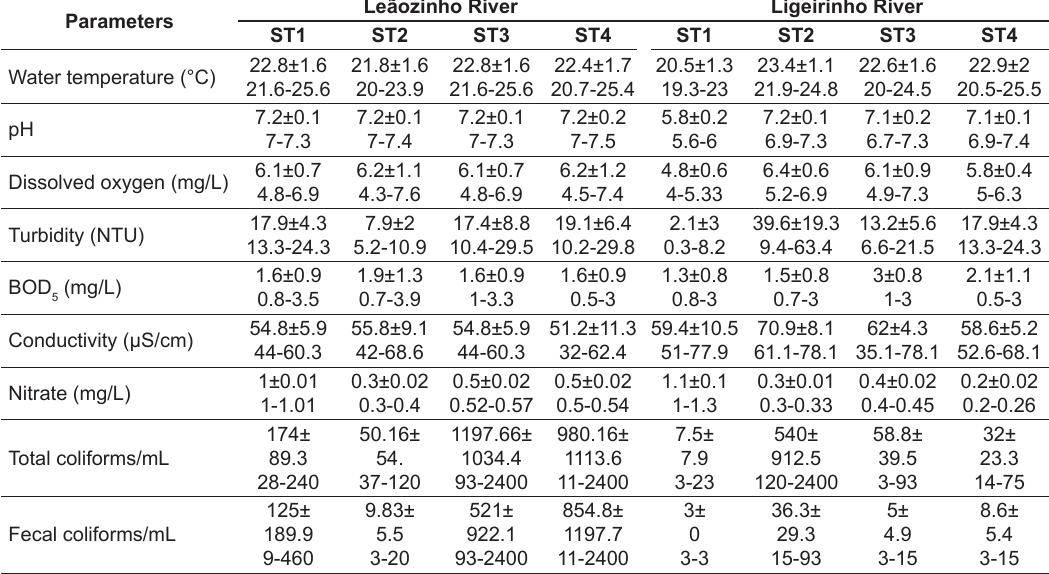
Table 3. Values of physicochemical and microbiological parameters measured at sites along the Leãozinho and Ligeirinho Rivers (Erechim, Rio Grande do Sul), by site (ST1-4), from November 2014 to April 2015. (means ± sd, min – max).